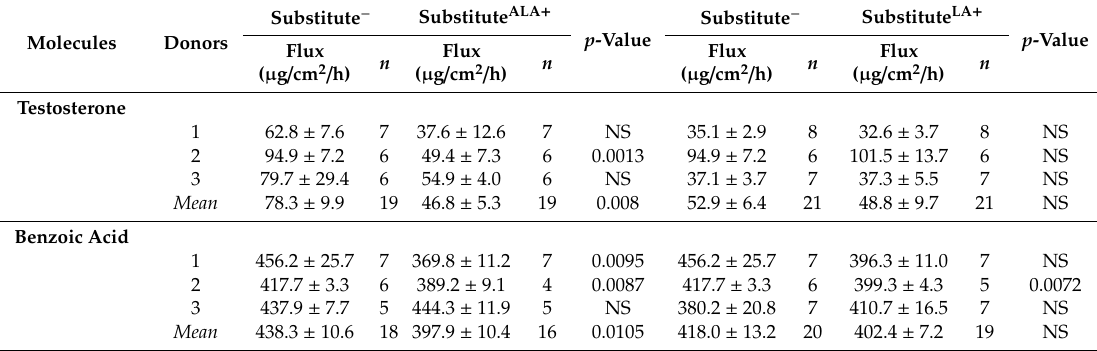
Table 1. Mean maximum fluxes of testosterone (2 h) and benzoic acid (3 h) through the skin substitutes.